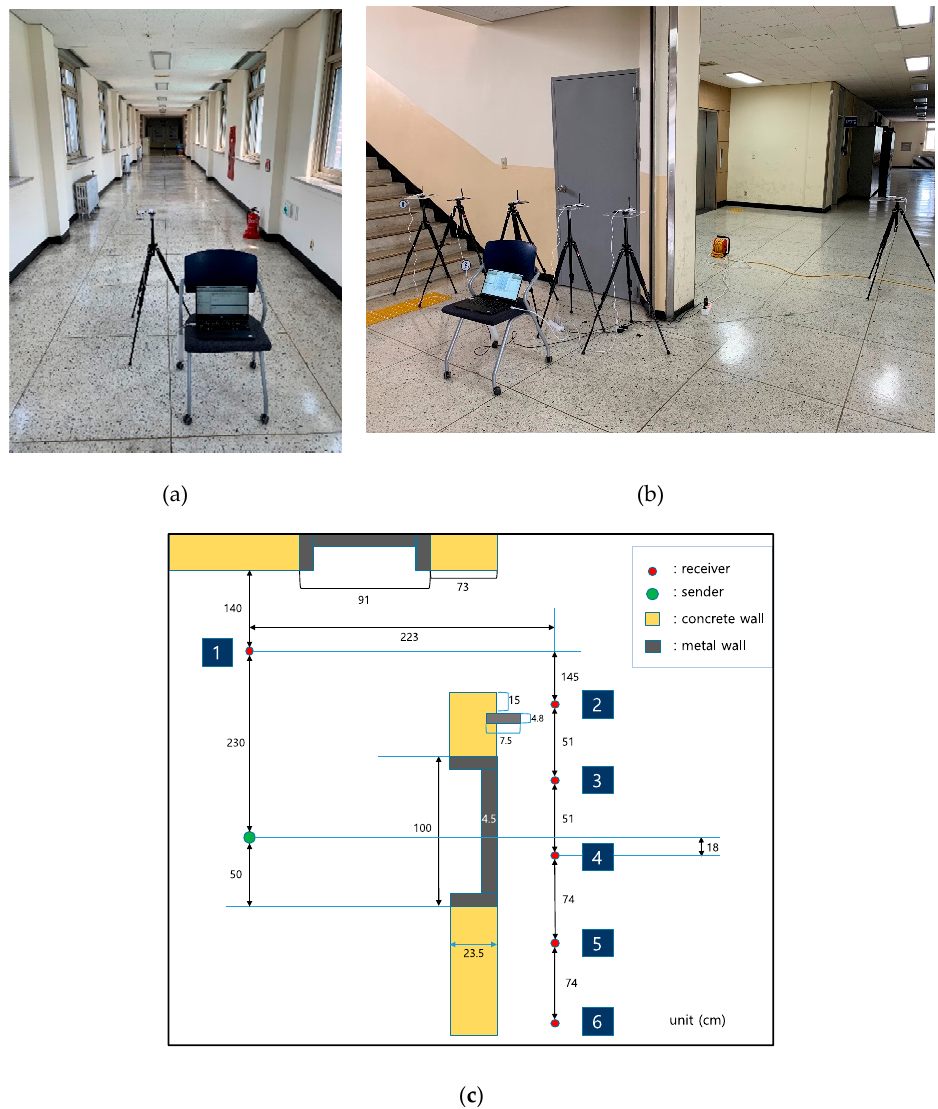
Figure 12. Measurement setup. ( a ) Photo for the LOS environment. ( b ) Photo for the NLOS environment. ( c ) Floor map for the NLOS environment.